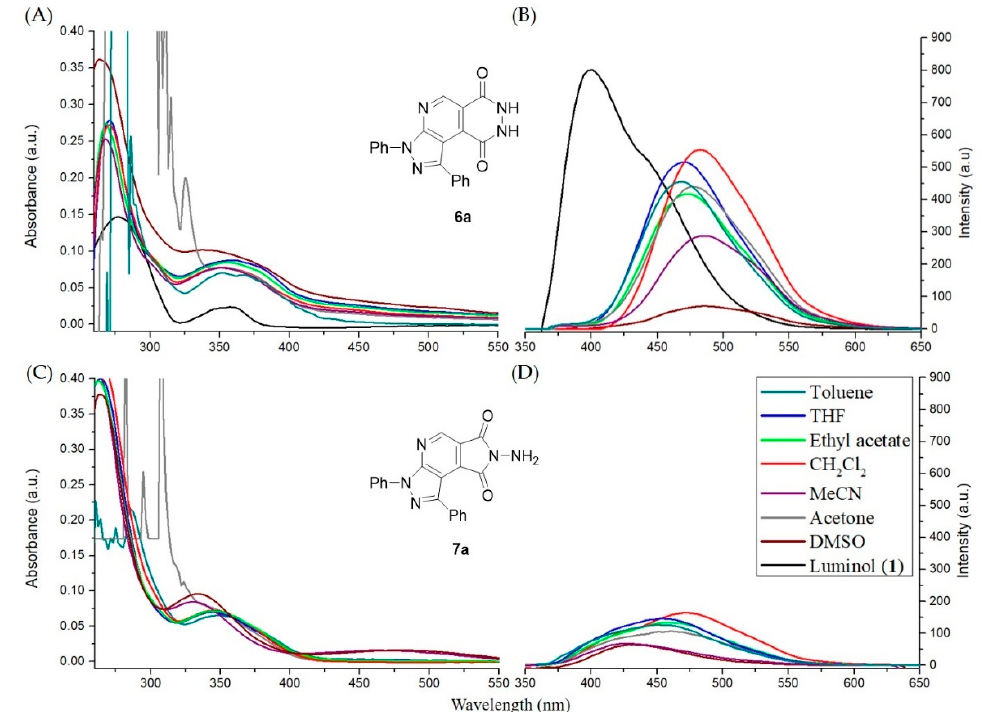
Figure 3. Photoluminescence spectra of luminol ( 1 ), pyrazolopyridopyridazine dione 6a and N -aminopyrazolopyrrolopyridine dione 7a in the different solvents. ( A ) Absorption and ( B ) emission spectra of luminol ( 1 ) and compound 6a . ( C ) Absorption and ( D ) emission spectra of compound 7a .